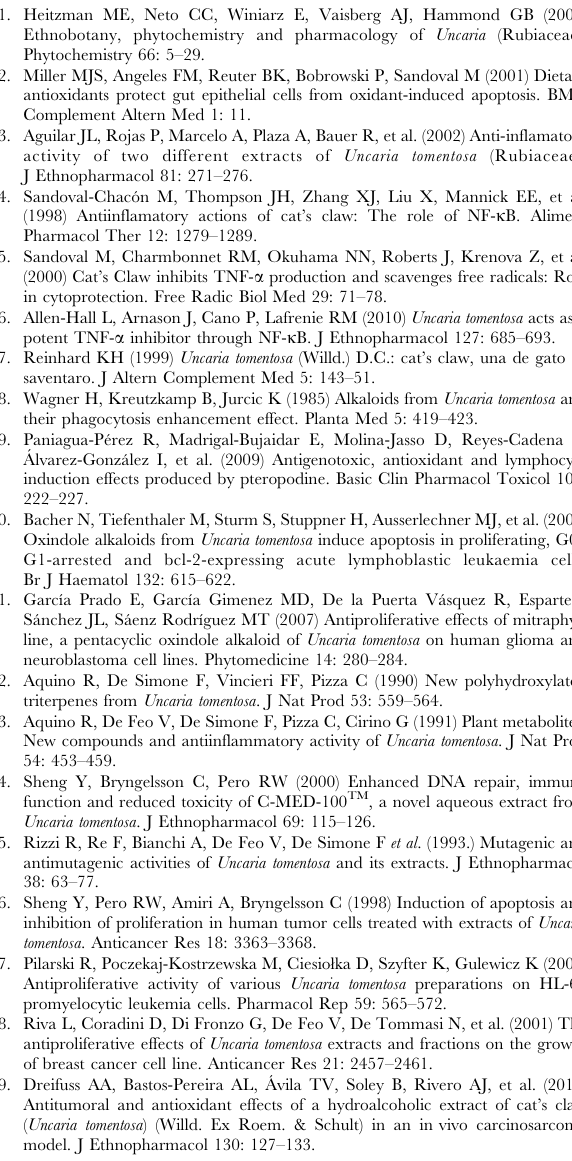
Figure S5 1 H NMR spectrum of the CHCl 3 fraction of U. tomentosa (400 MHz, DMSO-D 6 ). (TIF) Figure S6 13 C NMR spectrum of the CHCl 3 fraction of U. tomentosa (200 MHz, DMSO-D 6 ). (TIF) Figure S7 HSQC spectra of the CHCl 3 fraction of U. tomentosa (400 MHz, DMSO-D 6 ). (TIF) Figure S8 HMBC spectra of the CHCl 3 fraction of U. tomentosa (400 MHz, DMSO-D 6 ).